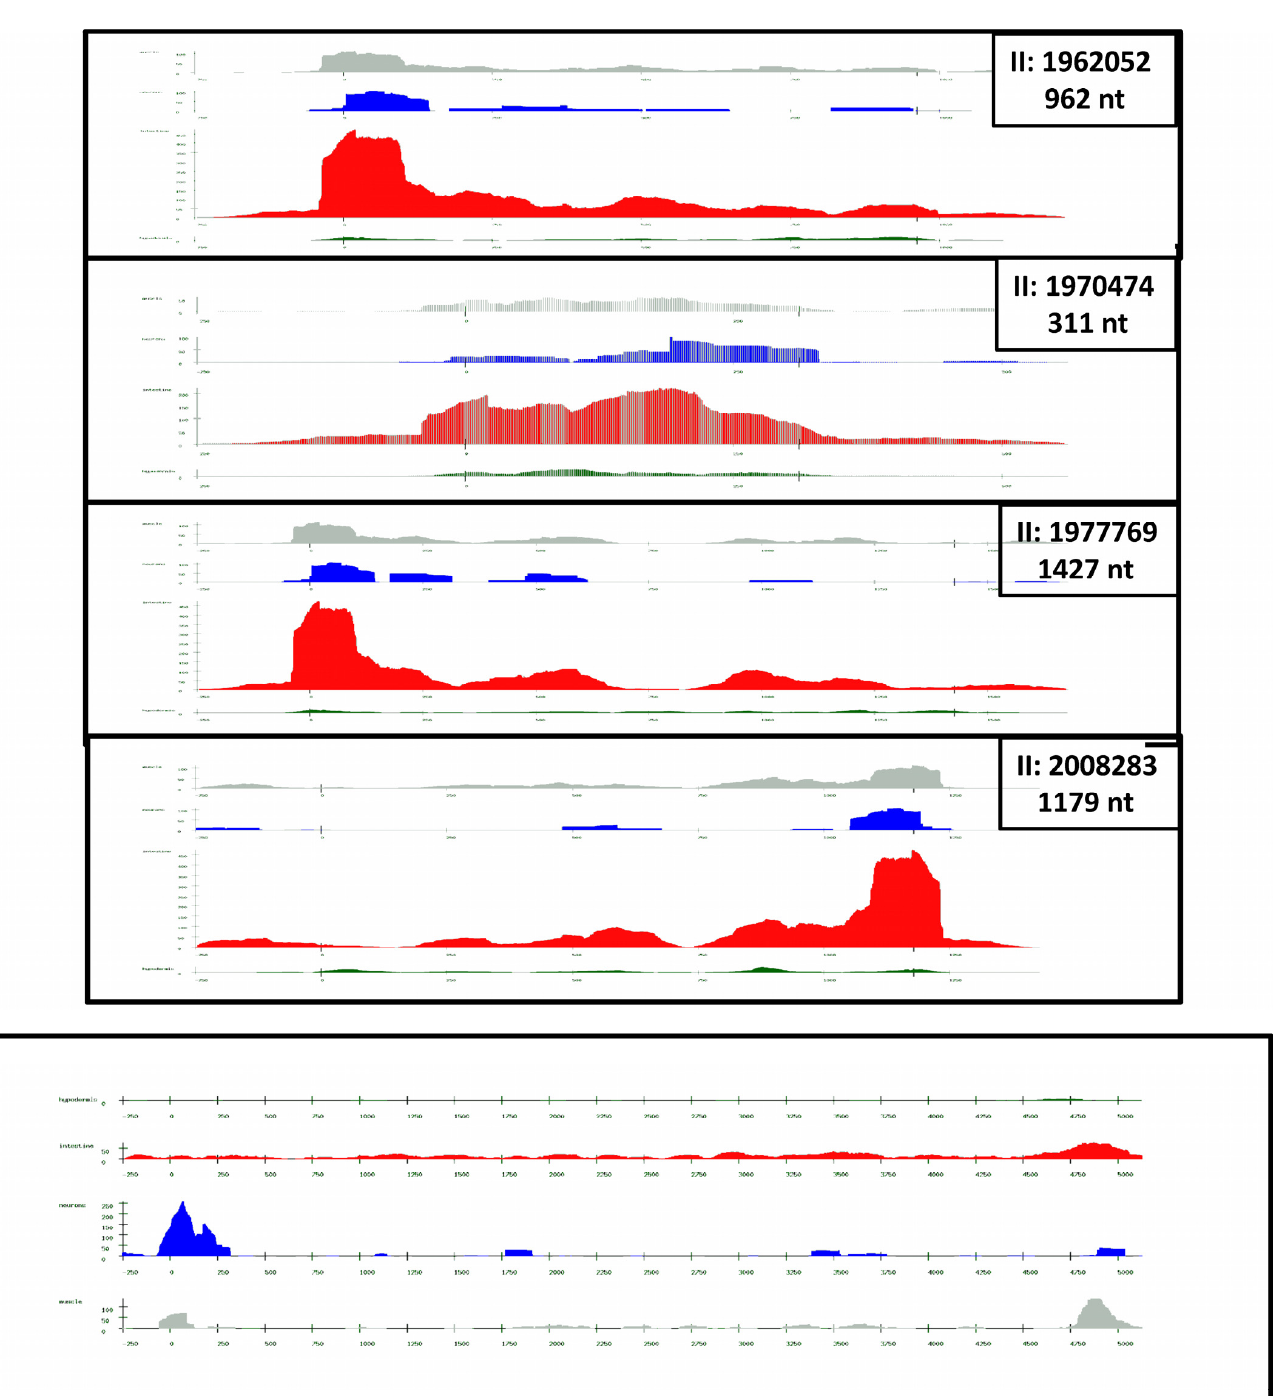
Figure 4. Transcription of 31 nt satellites and one Helitron gene. The transcription of four 31 nt satellites is shown in the upper four frames; the length of each satellite is also given. Note that the orientation of satellite II:2008283 is different from the other cases (Table 2). The images have been vertically compressed for a better comparison, although resolution is diminished. High resolution figures are available in Supplementary Data S2. The transcription of the F59H6.5 gene is shown in the lower figure; in the genome, it is found in close contact and before the II: 2008283 satellite; peaks of RNA-seq hits appear at the ends in both cases.